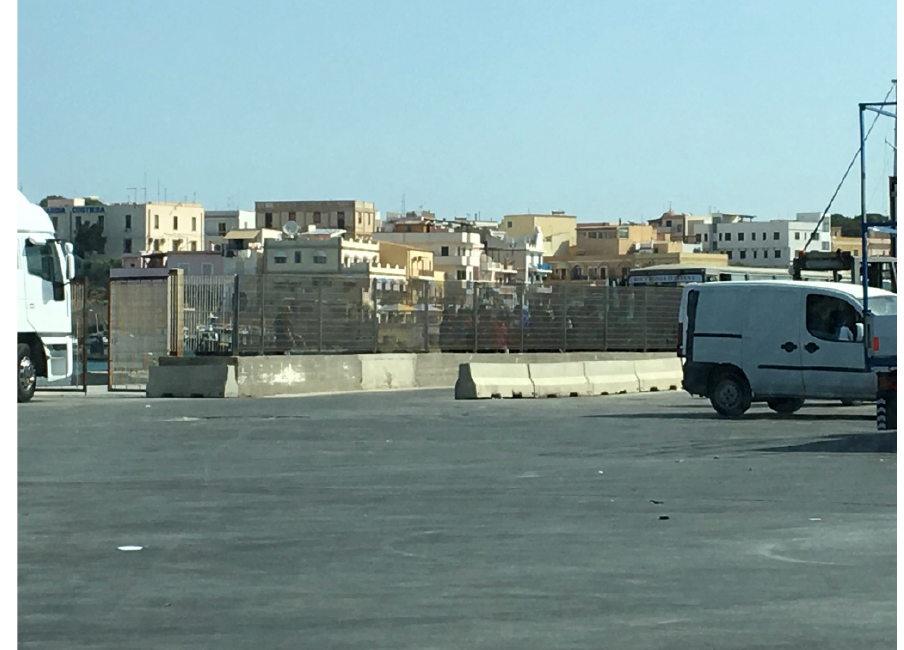
Figure 4. Lampedusa, June 2017, taken by the author. another step in the migrants’ non-place-ness as out- siders, outlaws,